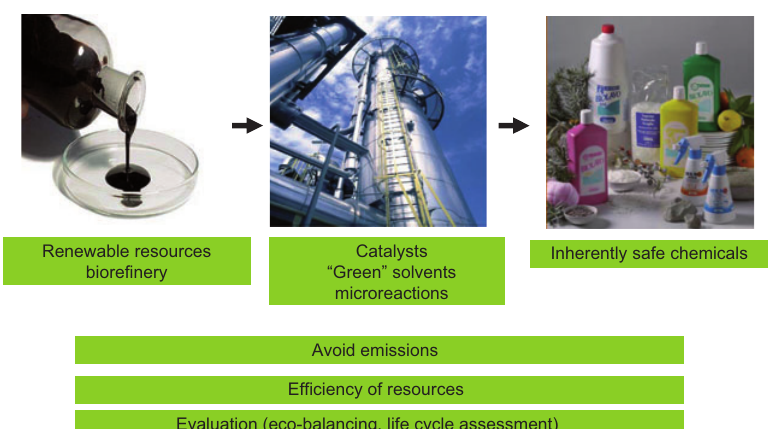
Figure 1 Pathway to a more sustainable chemical industry